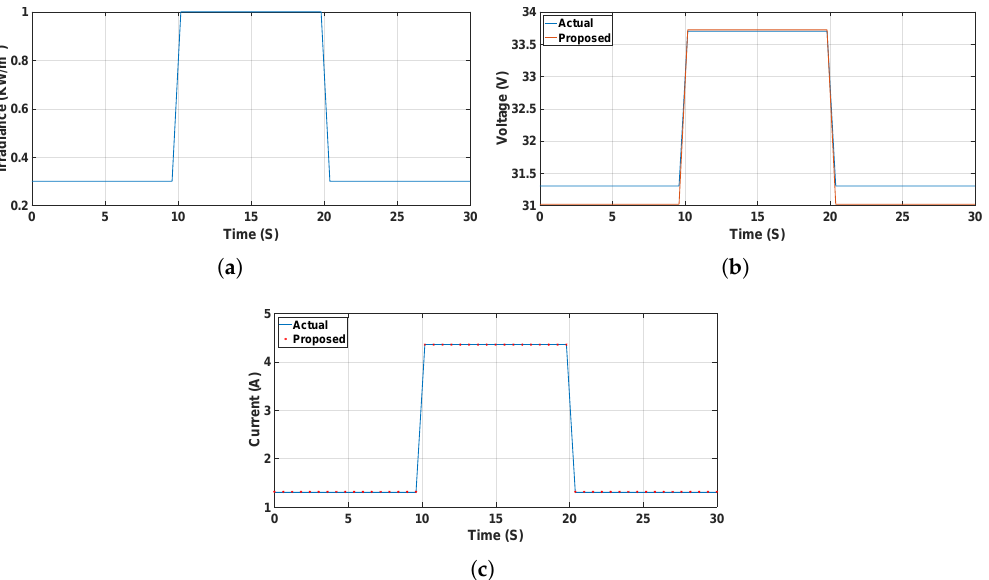
Figure 9. ( a ) Very steep gradient ( b ) accuracy of the Proposed algorithm in finding V mpp at very steep gradient ( c ) accuracy of the Proposed algorithm in finding I mpp at very steep gradient.